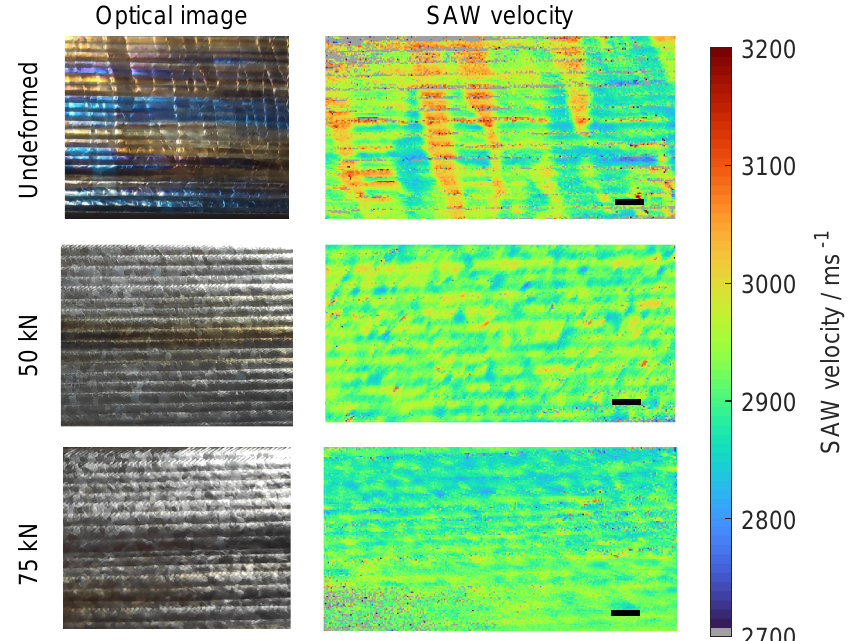
Figure 7. Optical photographs ( left column ) and SRAS velocity maps ( right column ) from sidewall of as-deposited Ti-6Al-4V WAAM specimens in ( top row ) sm undeformed state and post- ( middle row ) 50 kN and ( bottom row ) 75 kN interpass rolling. Scale bar in velocity maps indicates 2